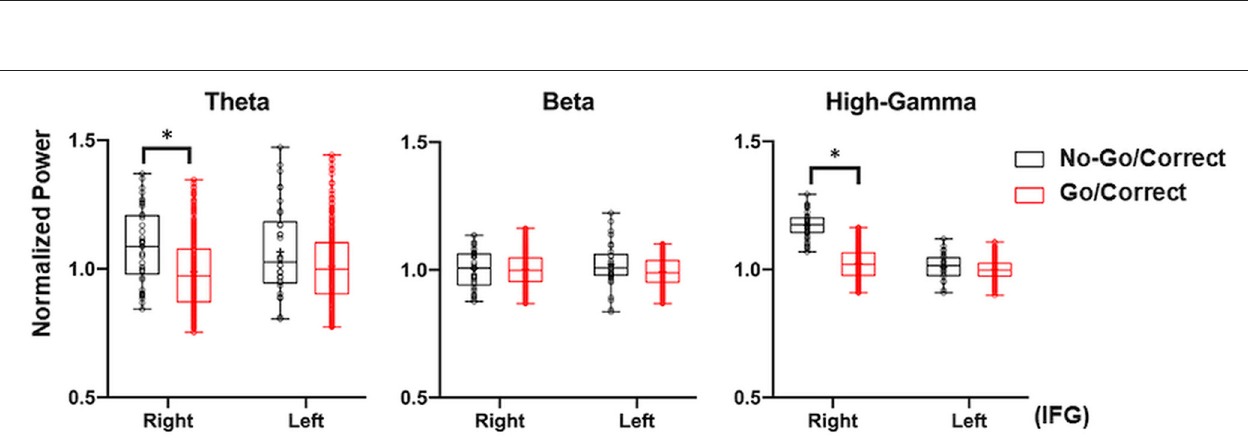
FIGURE 7 | Illustration of the right and left IFG with cross-patient power analysis in Go/Correct and No-Go/Correct conditions. The normalized power in theta (4–8Hz), beta (12–40Hz), and high-gamma (HG, 80–200Hz) were calculated by mean value, interquartile range (box plot), and maximal/minimal (error bar). In No-Go/Correct conditions, the power of theta, beta, and HG were higher than those in Go/Correct condition, with statistical significance in theta and HG power over the right IFG (marked by an asterisk, p < 0.05, corrected by the Tukey–Kramer Test).